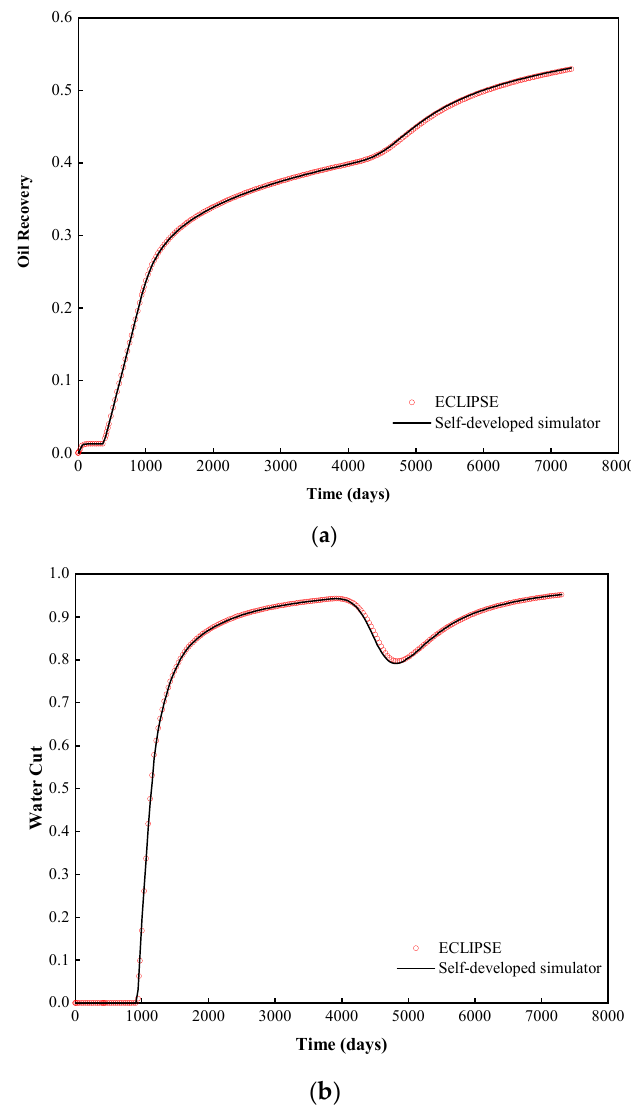
Figure 3. The comparison validation of the self-developed simulator for polymer flooding [34]. ( a ) Oil recovery. ( b ) Water cut.